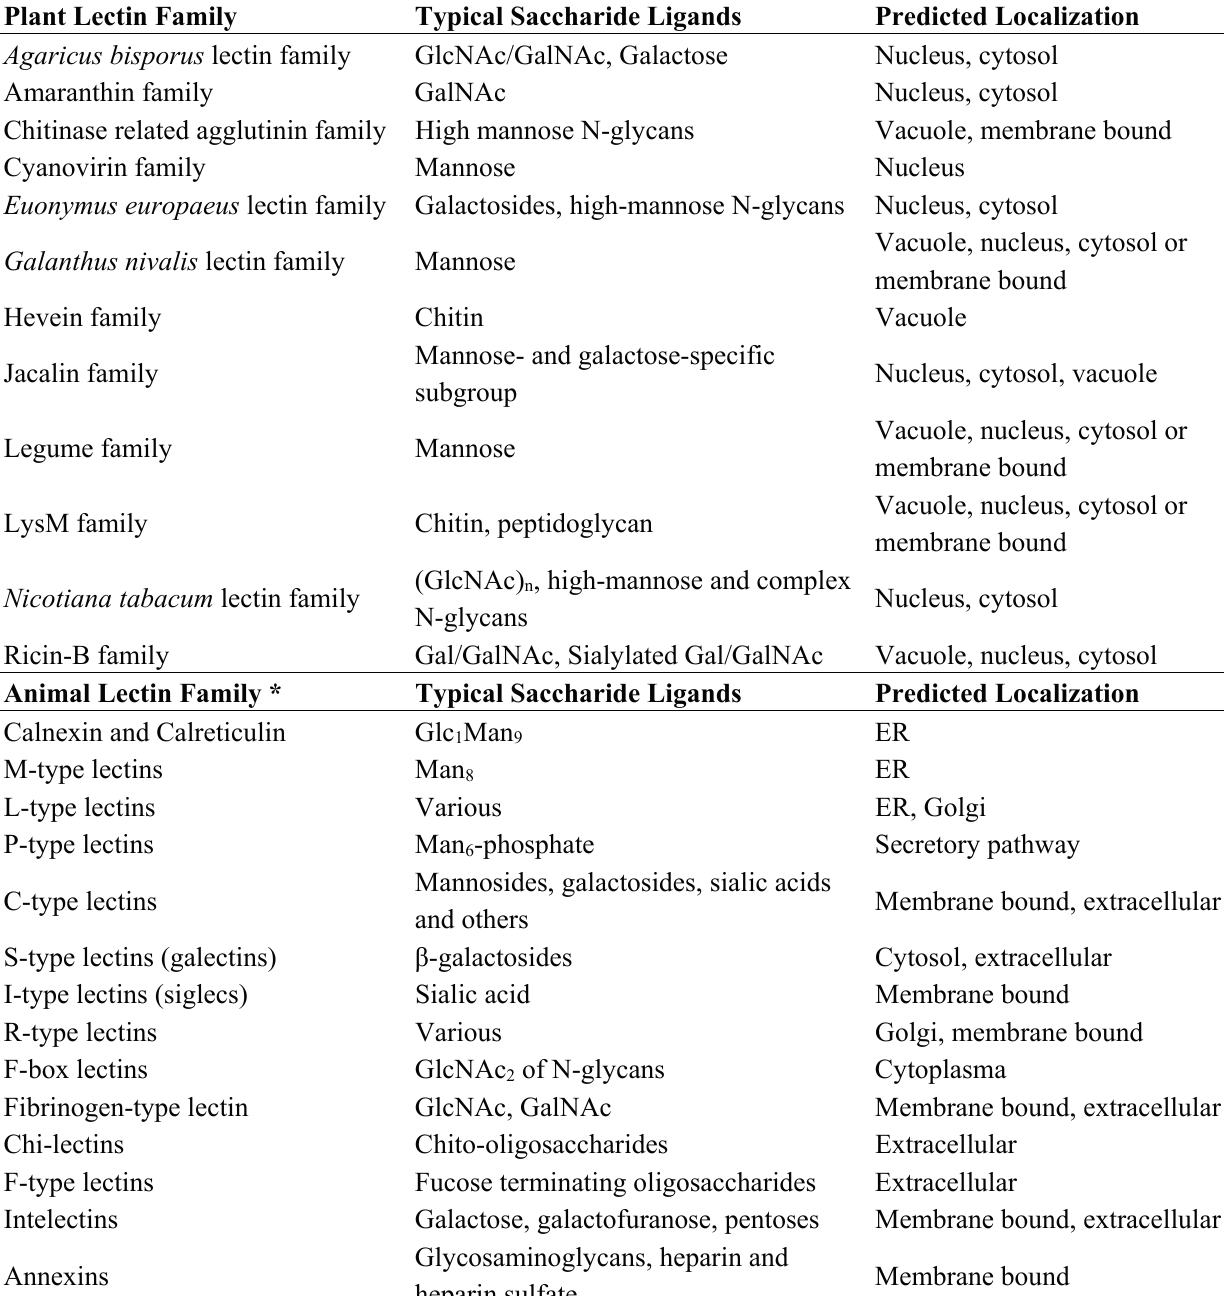
Table 1. Lectin families in plants and